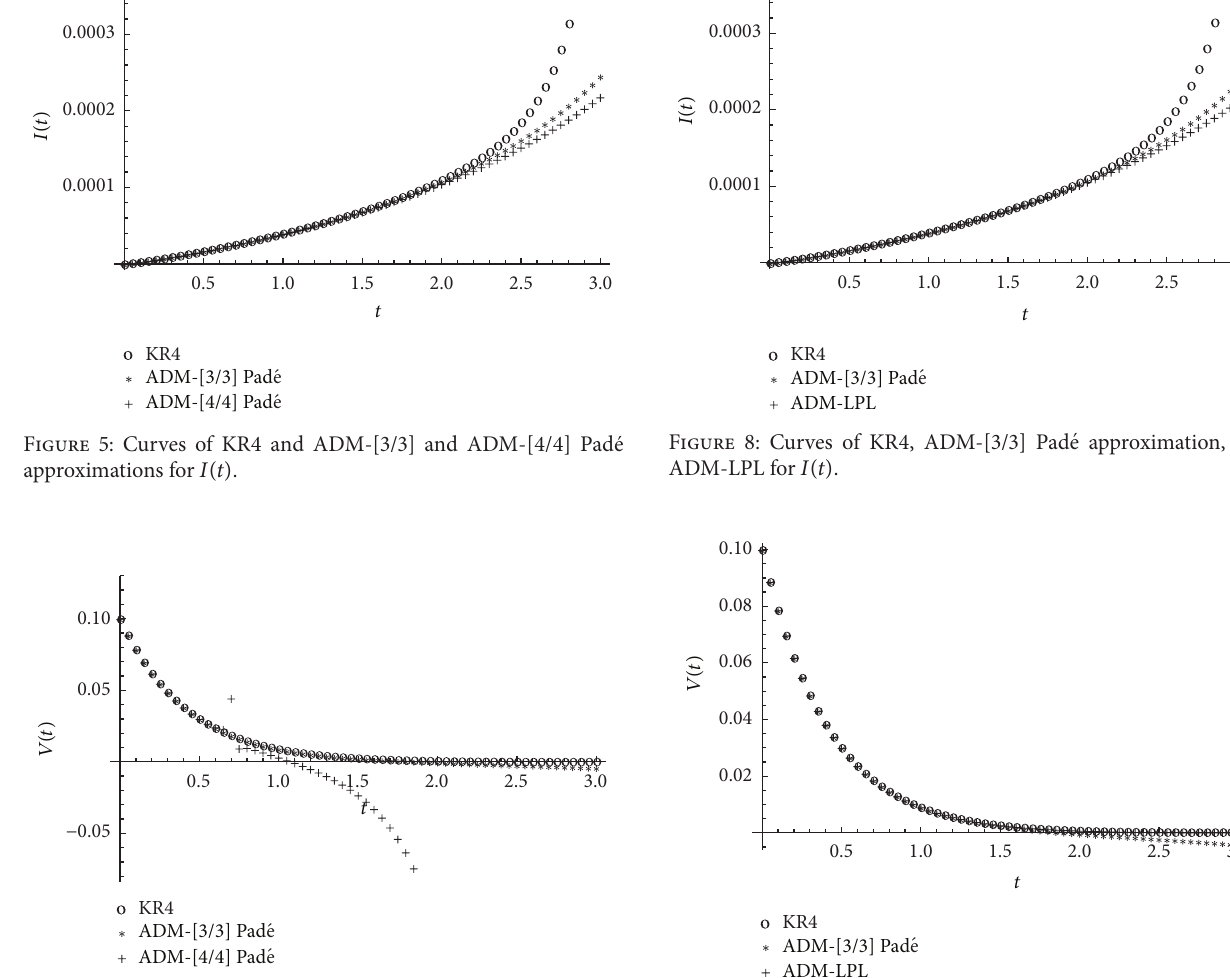
Figure 9: Curves of KR4, ADM-[3/3] Pad´e approximation, and ADM-LPL for 𝑉(𝑡)